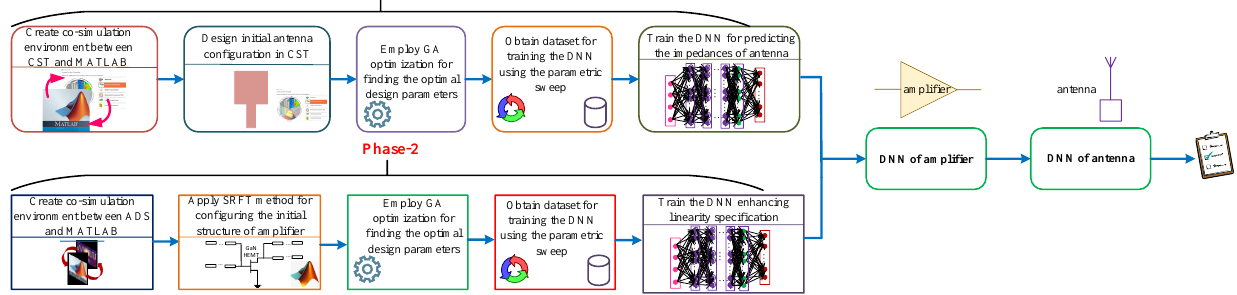
Figure 1. Comprehensive overview around the proposed methodology where two LSTM-based DNNs are employed for modeling antenna and PA.